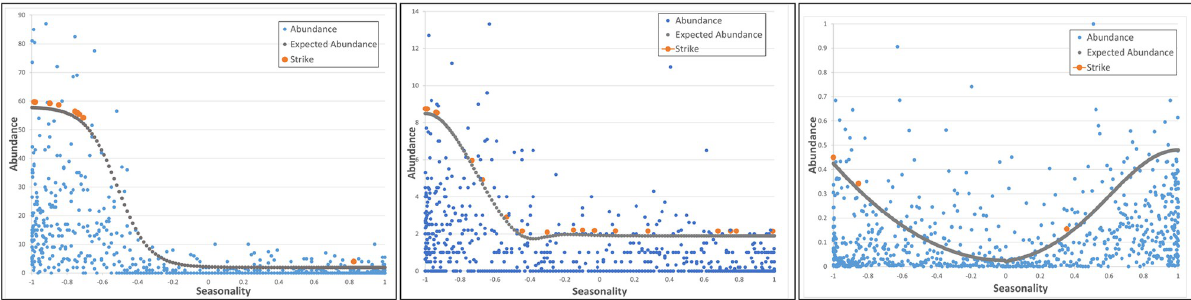
Fig 2. Hazard species—abundance (vertical axis) against solar day (seasonality) (horizontal axis). Blue markers indicate abundance on a particular day, orange markers shows days where at least one individual of the relevant hazard species was involved in a strike occurrence, and grey markers give the expected abundance on any day. (a) Cattle Egret abundance, seasonality, and expected abundance, (b) Nankeen Kestrel abundance, seasonality and expected abundance, (c) Straw-necked Ibis abundance, seasonality, and expected